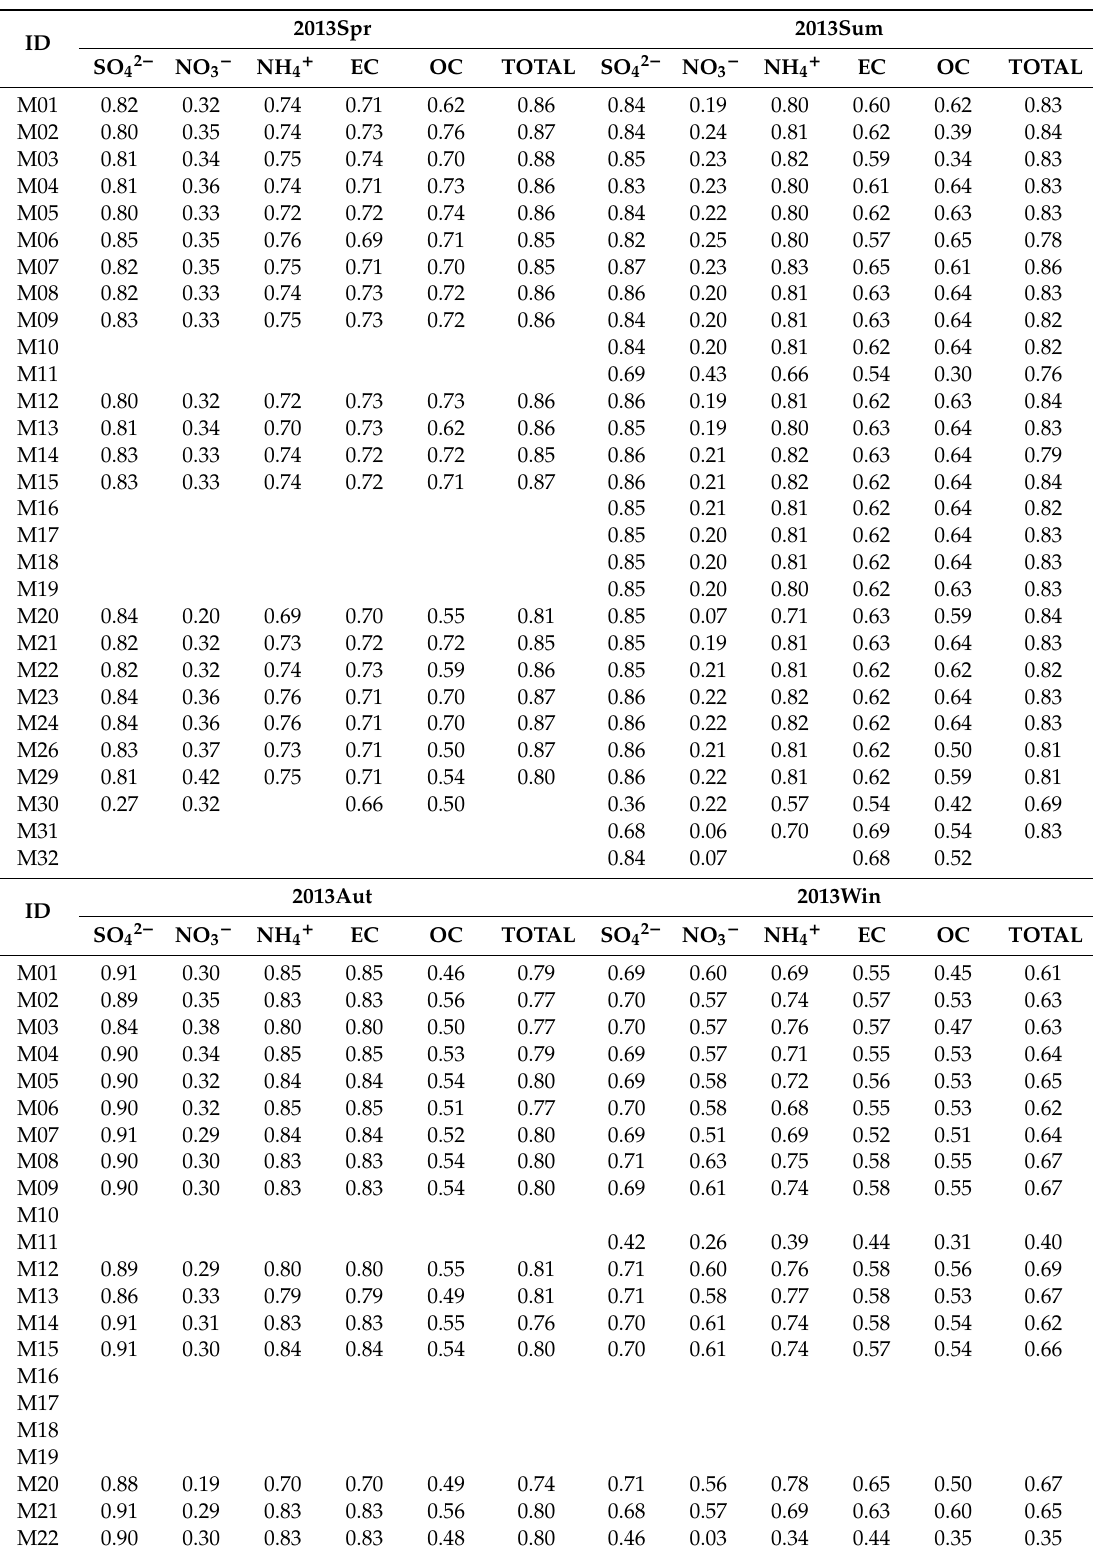
Table A2. Individual model performance (IoA) for